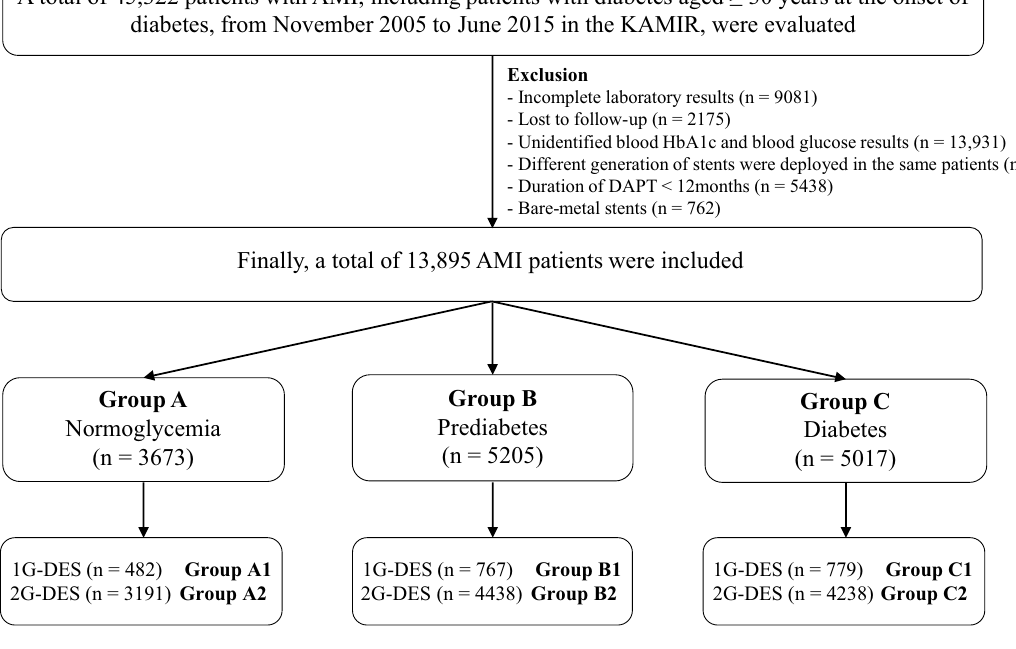
Figure 2. Study flow chart. AMI, acute myocardial infarction; KAMIR, Korea AMI Registry; HbA1c, hemoglobin A1c; 1G, first-generation; 2G, second-generation; DES, drug-eluting stent; DAPT, dual antiplatelet